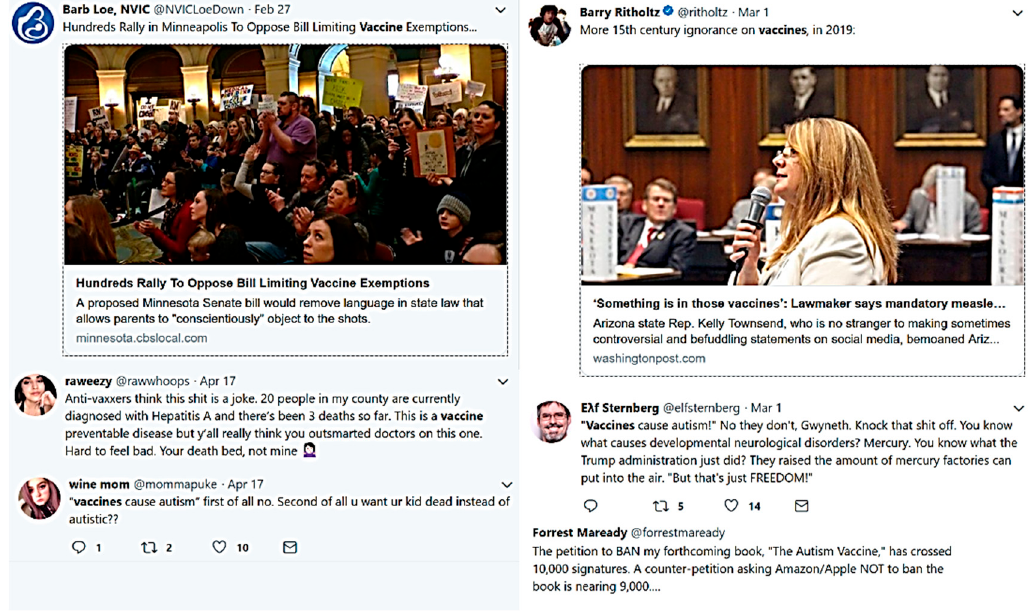
Figure 2. Six randomly selected tweets in the dataset.